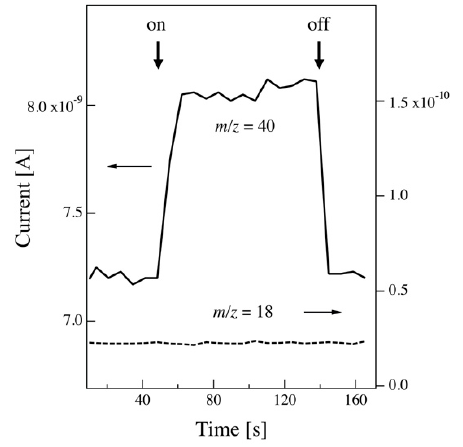
Figure 1. The background intensity of the m/z = 18 and 40 mass peaks in the sample chamber when the Ar cluster ion beams enter (on) and are shut off (off) by the deflector.